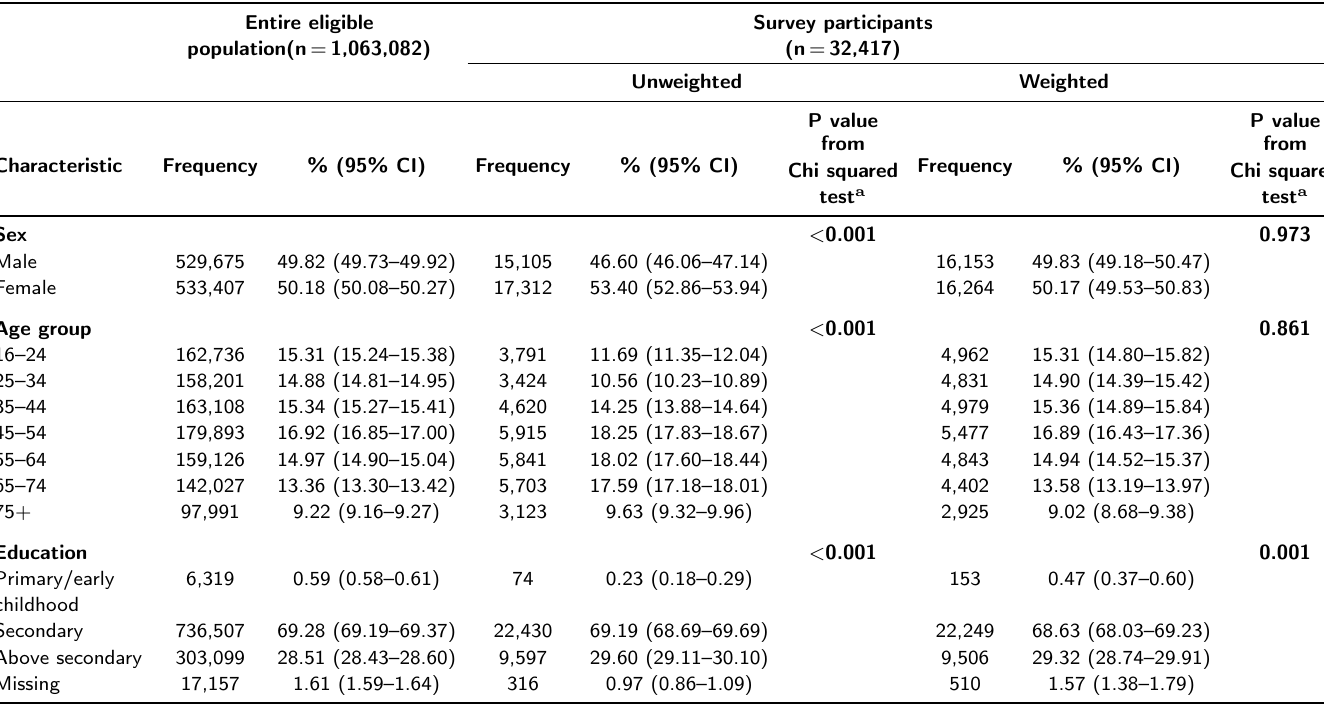
Table 1: Characteristics of all those eligible for the 2017 Central Denmark Region How are you? survey and the survey participants (unweighted and weighted according to sampling and participation weights) Entire eligible Survey participants population(n =